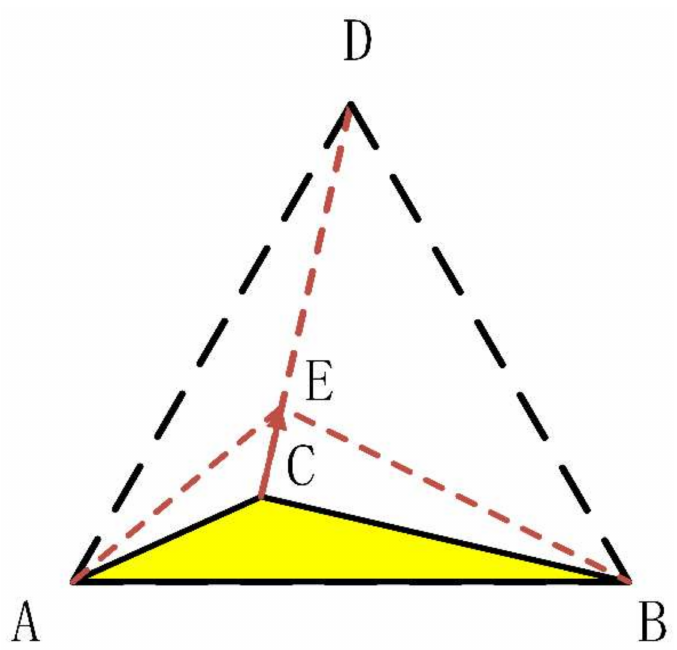
Figure 1. Preliminary optimization schematic for unstructured meshes using geometric principles.